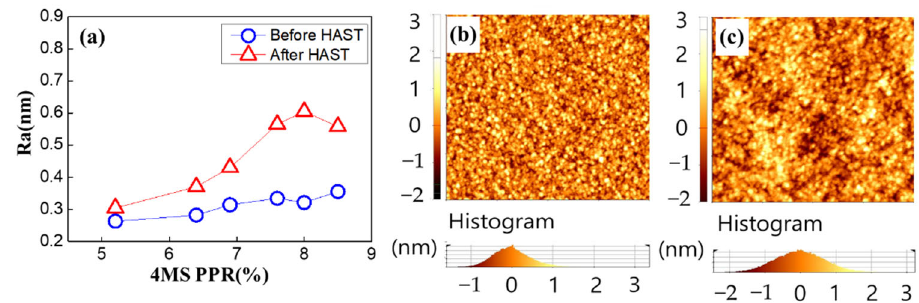
Figure 14. AFM analysis of film roughness ( a ) before and after the HAST. ( b ) Two ‐ dimensional image (1 μ m× 1 μ m) of 4MS PPR − 8.5% as depo. ( c ) Two ‐ dimensional image (1 μ m× 1 μ m) of 4MS (1 µ m × 1 µ m) of 4MS PPR − 8.5% as depo. ( c ) Two-dimensional image (1 µ m × 1 µ m) of 4MS PPR PPR − 8.5% after HAST. − 8.5% after HAST.